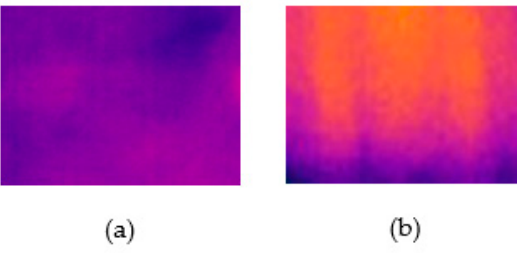
Figure 2. Thermographic image of a PV module: ( a ) dirty; ( b ) dirty after light rain.